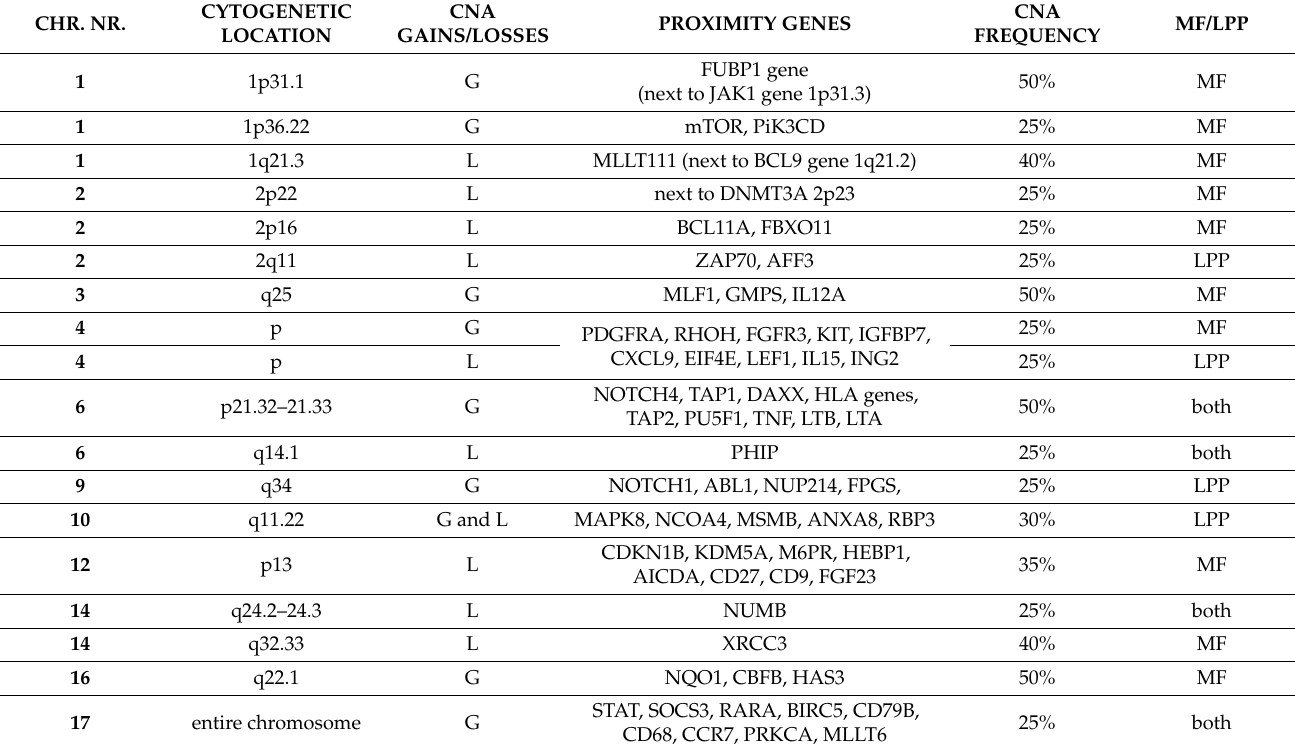
Table 4. Summary of common CNAs that affect predominantly LPP or